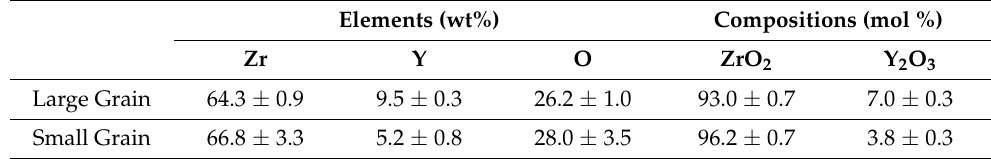
Table 4. Chemical compositions of large and small grains corresponding to cubic and tetragonal phases characterized by EDS spot